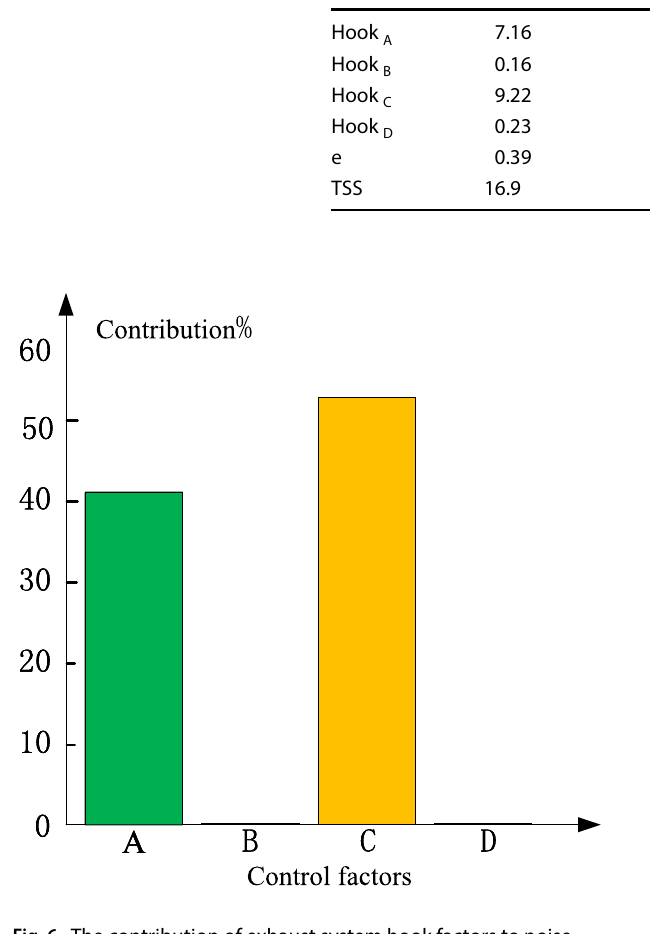
Fig. 6 The contribution of exhaust system hook factors to